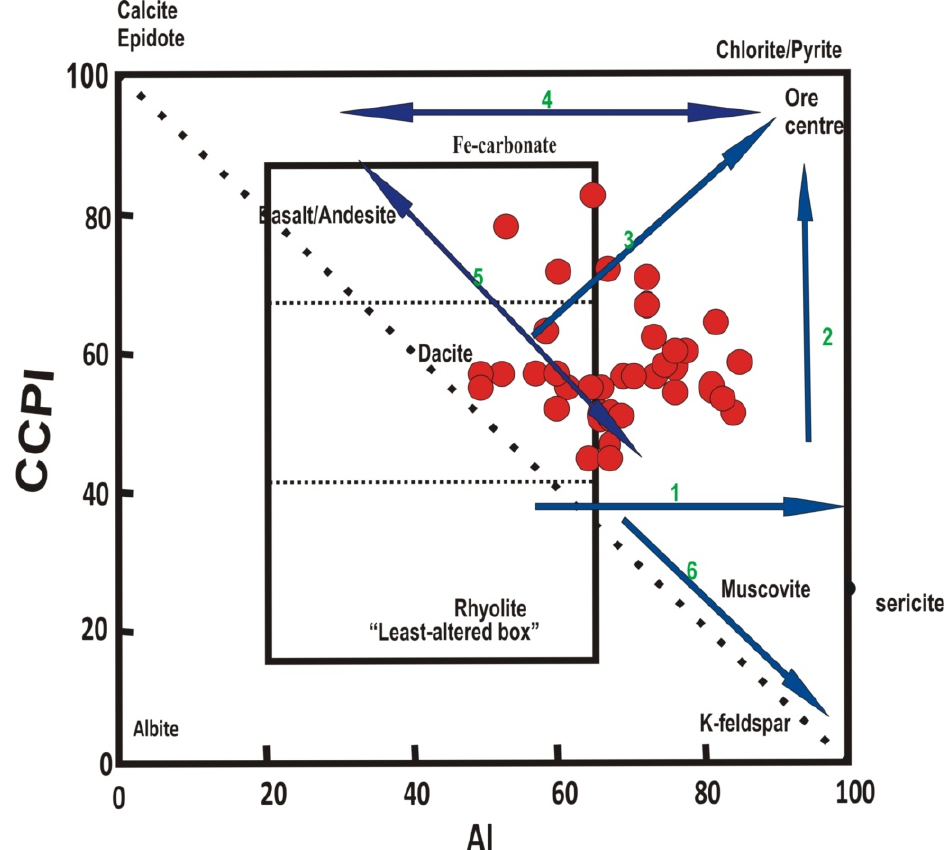
Figure 10. Felsic volcanic rocks plotted in the Alteration Box Plot [61] using Alteration Index (AI) versus chlorite-carbonate-pyrite index (CCPI), which shows a strong correlation with Trend 1 and weak correlation with Trend 2, 3 and 5. AI = 100 (K 2 O + MgO)/(K 2 O + MgO + Na 2 O + CaO); CCPI = 100 (MgO + FeO)/(MgO + FeO + Na 2 O + K 2 O). (Data source: Table S1).